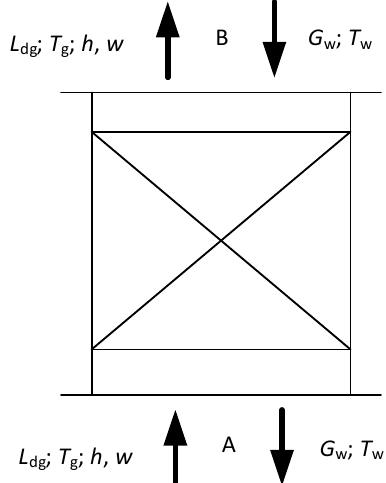
Fig. 2. Flow scheme and parameters of heat carriers in direct contact heat